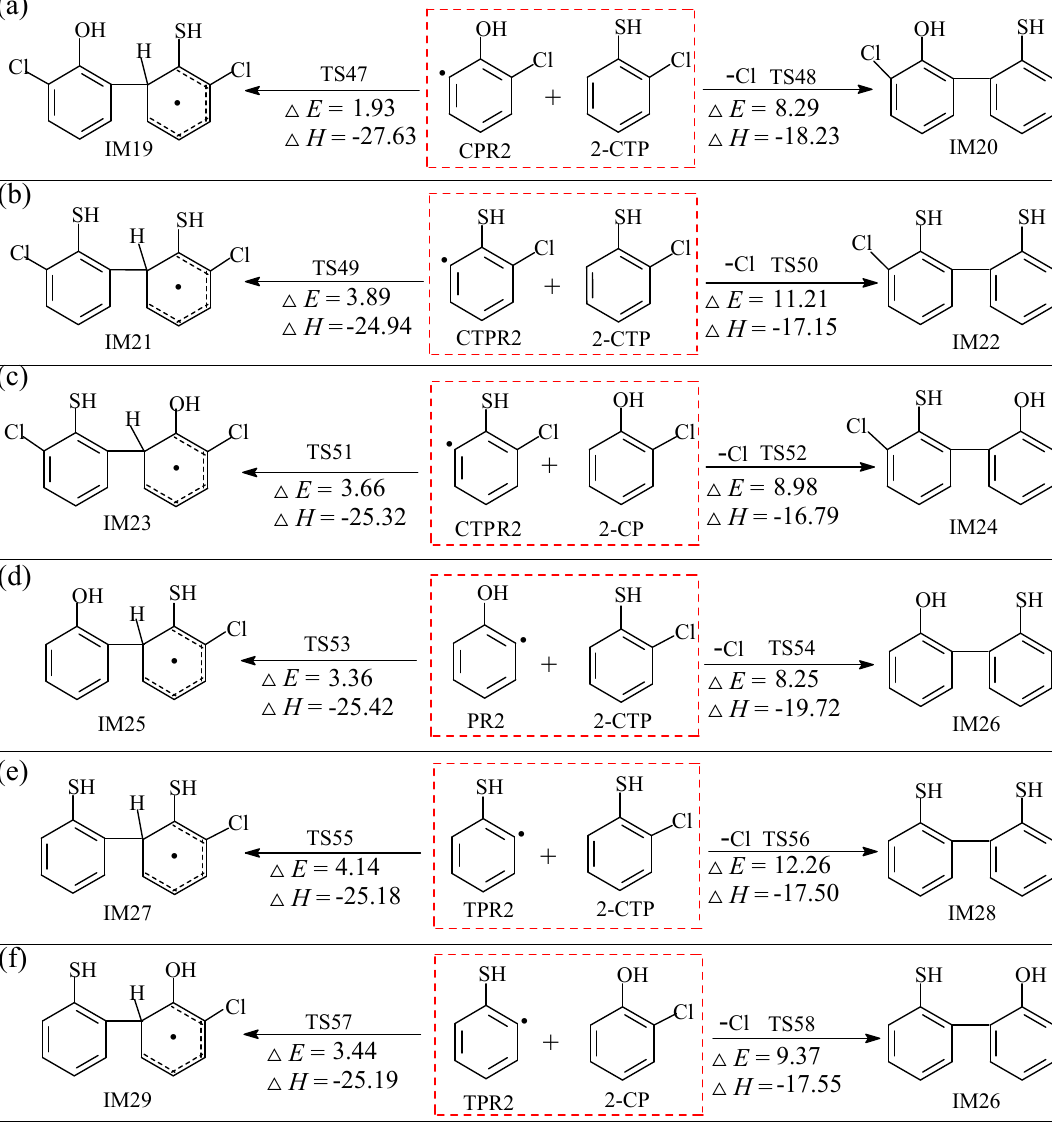
Figure 4. Pre-PCDT/DF formation routes embedded with the potential barriers Δ E (in kcal/mol) and reaction heats Δ H (in kcal/mol) from the coupled reactions of CPR2 with 2-CTP ( a ), CTPR2 with 2-CTP ( b ), CTPR2 with 2-CP ( c ), PR2 with 2-CTP ( d ), TPR2 with 2-CTP ( e ), and TPR2 and 2-CP ( f ). Δ H is calculated at 0 K.